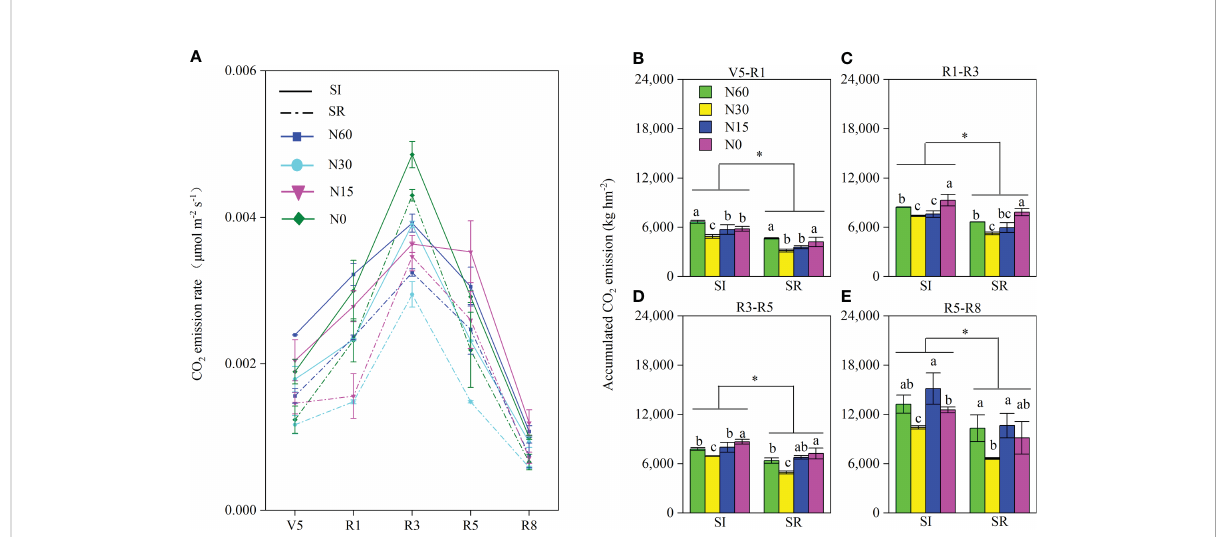
FIGURE 9 Effects of straw incorporation and nitrogen application on soil CO2 emissions properties. Different lower-case letters indicate signi fi cant differences under different N application rates ( LSD , P < 0.05). Data were shown as mean ± S.D. (n=3). SI, straw incorporation; SR, straw removal; N60, convention N (60 kg N ha -1 ); N30, reduced N by 50% (30 kg N ha -1 ); N15, reduced N by 75% (15 kg N ha -1 ); N0, zero N (0 kg N ha -1 ); V5, the fi fth trifoliolate stage of soybean; R1, the beginning fl owering stage of soybean; R3, the beginning pod stage of soybean; R5, the beginning seed stage of soybean; R8, the full-maturity stage of soybean; V5-R1, the growth stage from V5 to R1; R1-R3, the growth stage from R1 to R3; R3-R5, the growth stage from R3 to R5; R5-R8, the growth stage from R5 to R8. The asterisk "*" indicate signi fi cant differences (P < 0.05) between straw incorporation and straw removal. (A) , the CO2 emission rate at the different growth stages of soybean; (B) , the accumulated CO2 emissions from V5 to R1; (C) , the accumulated CO2 emission from R1 to R3; (D) , the accumulated CO2 emission from R3 to R5; (E) , the accumulated CO2 emission from R5 to